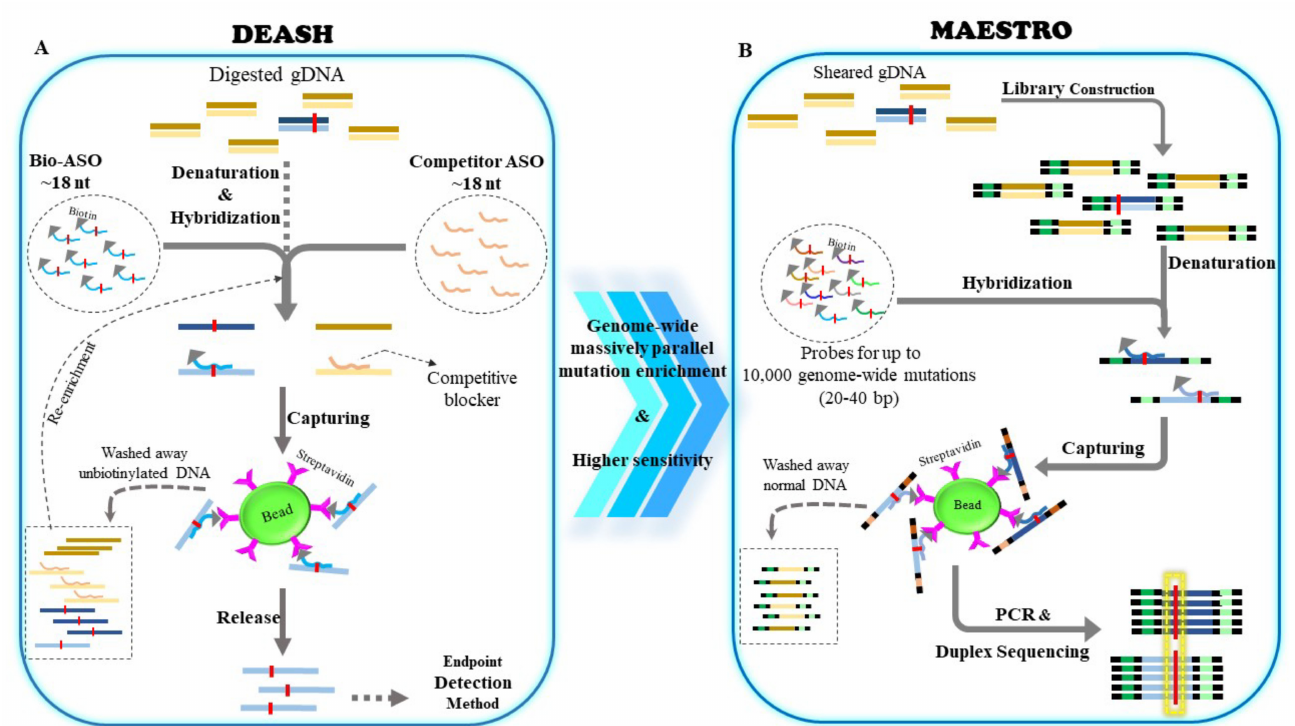
Figure 3. ( A ) Principles of DNA enrichment via allele-specific hybridization (DEASH), and minor- allele-enriched sequencing through recognition oligonucleotides (MAESTRO). The biotinylated allele-specific oligonucleotide (bio-ASO) is designed to bind mutant strands, while competitor ASO attaches to wild-type strands. Following denaturation and hybridization, the bio-ASO/target hybrids are captured by streptavidin-coated beads. The unbound DNA can undergo further cycles of DEASH. The enriched single-stranded targets are eluted and purified; ( B ) workflow for minor-allele-enriched sequencing through recognition oligonucleotides (MAESTRO) technique. The underlying principle is similar to DEASH, although MAESTRO operates without competitive blockers and provides genome-wide massively parallel enrichment. Following NGS library construction and barcoding top and bottom DNA strands, the biotinylated probes complementary for up to 10,000 genome-wide mutations are employed to bind mutant strands. Afterwards, the mutation-containing strands are preferentially captured by streptavidin-coated beads, are amplified, and undergo duplex